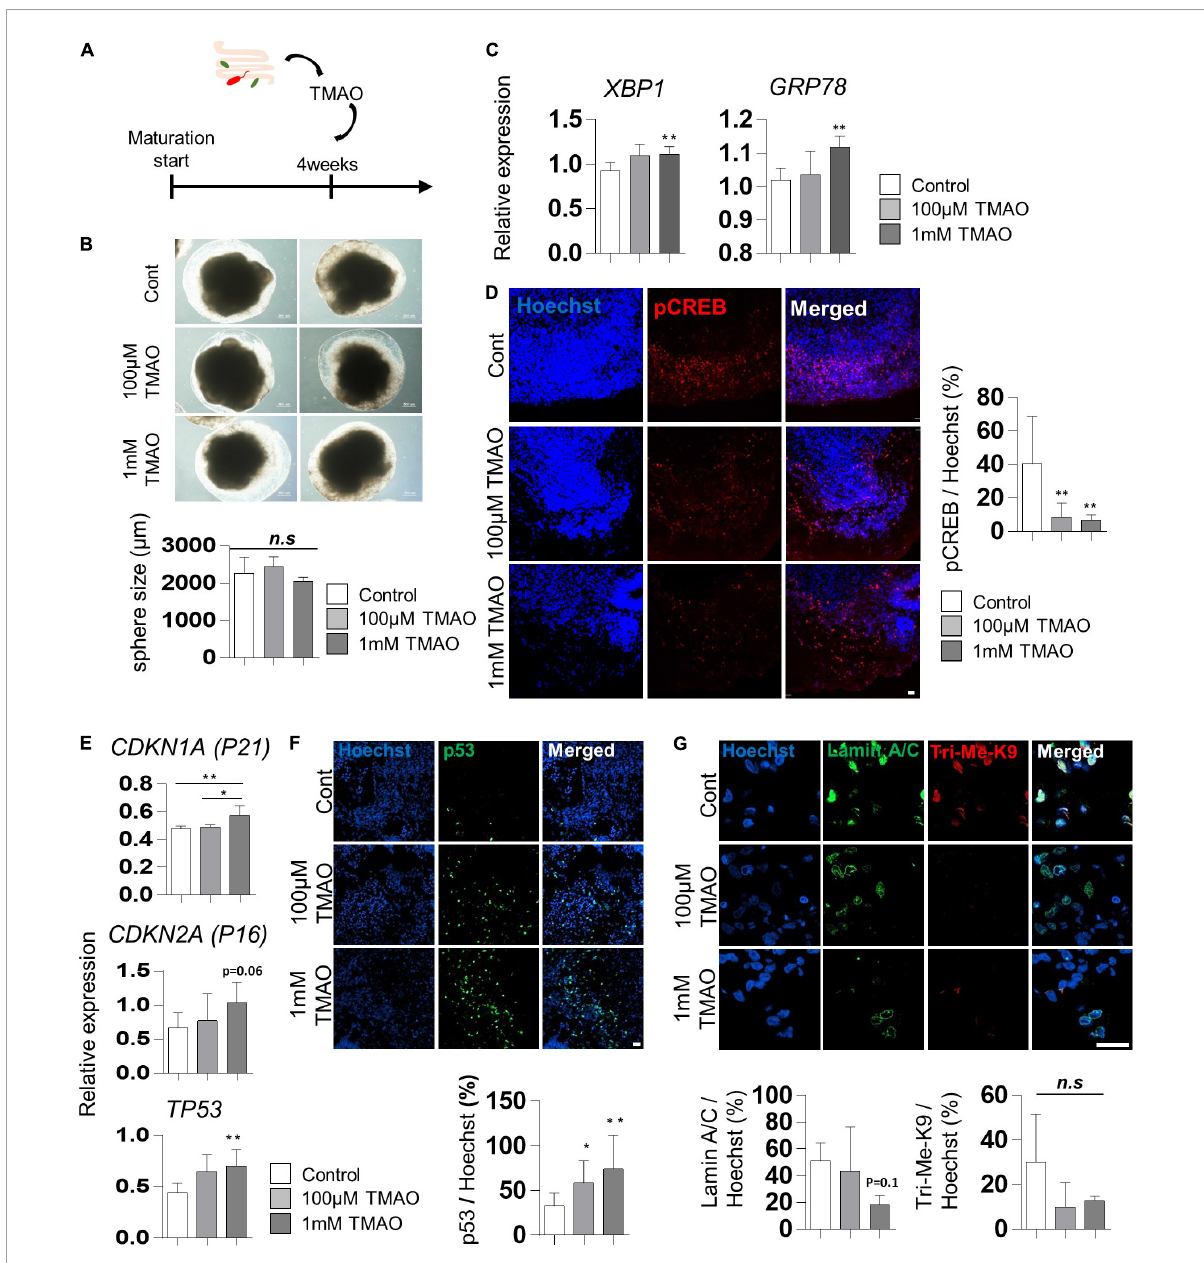
FIGURE2 Aging-associated molecular phenotypes of trimethylamine N -oxide (TMAO)-treated midbrain organoids. (A) Schematics of TMAO treatment in midbrain organoid. (B) Representative phase-contrast images (upper) and quantification of organoid size (lower). (C) Relative mRNA expression levels of XBP1 and GRP78 . (D) Relative IF images (left) and quantification of phosphorylated cAMP response element-binding protein-positive cells in indicated groups (8WMs). Hoechst was used for counter nuclei staining. (E) The relative mRNA expression level of CDKN1A, CDKN2A, and TP53 . (F) Representative IF images (upper) and quantification (lower) of the p53-expressing cells in the indicated organoid group. (G) Representative IF images (upper) and quantification (lower) of the Lamin A/C and Tri-Me-K9 in the indicated organoid group. Data are AVE ± SD [ P < 0.05(*), P <